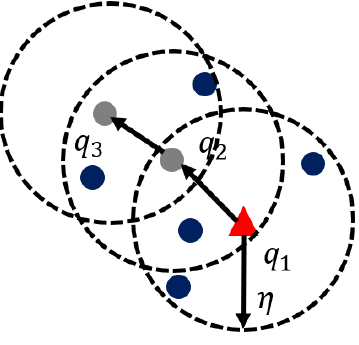
Figure 2. Example of direct density-reachability and density-reachability, supposing ω = 4. The dotted line indicates the maximum distance from the sample. “ (cid:78) ” is the sample in the boundary domain, and the “circle shape” is the majority class. q 2 is directly density-reachable by q 1 , and q 3 is density-reachable by q 1